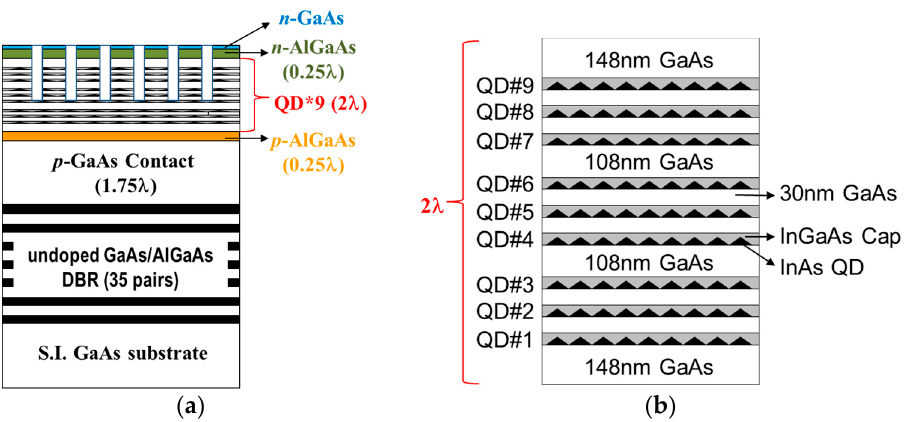
Figure 1. Schematic ( a ) device structure and ( b ) active region of quantum-dot (QD) photonic-crystal surface-emitting lasers PCSEL with bottom distributed Bragg reflector (DBR).